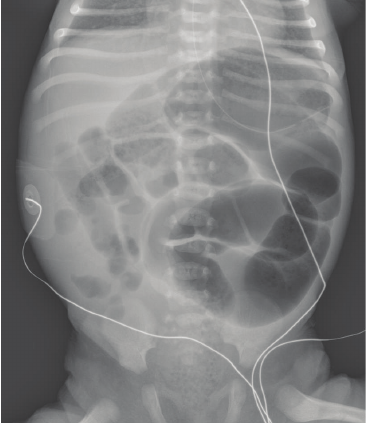
Figure 1: Abdominal radiograph obtained on HD 2 demonstrated dilation of the proximal bowel with normal caliber distal bowel and a paucity of air in the